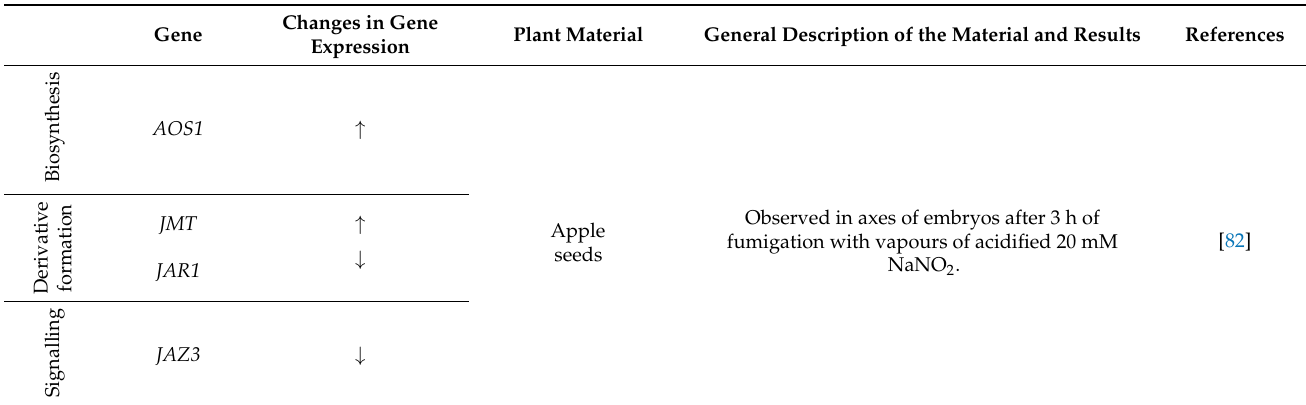
Table 5. NO-dependent changes in the expression of genes related to JA metabolism and signalling in